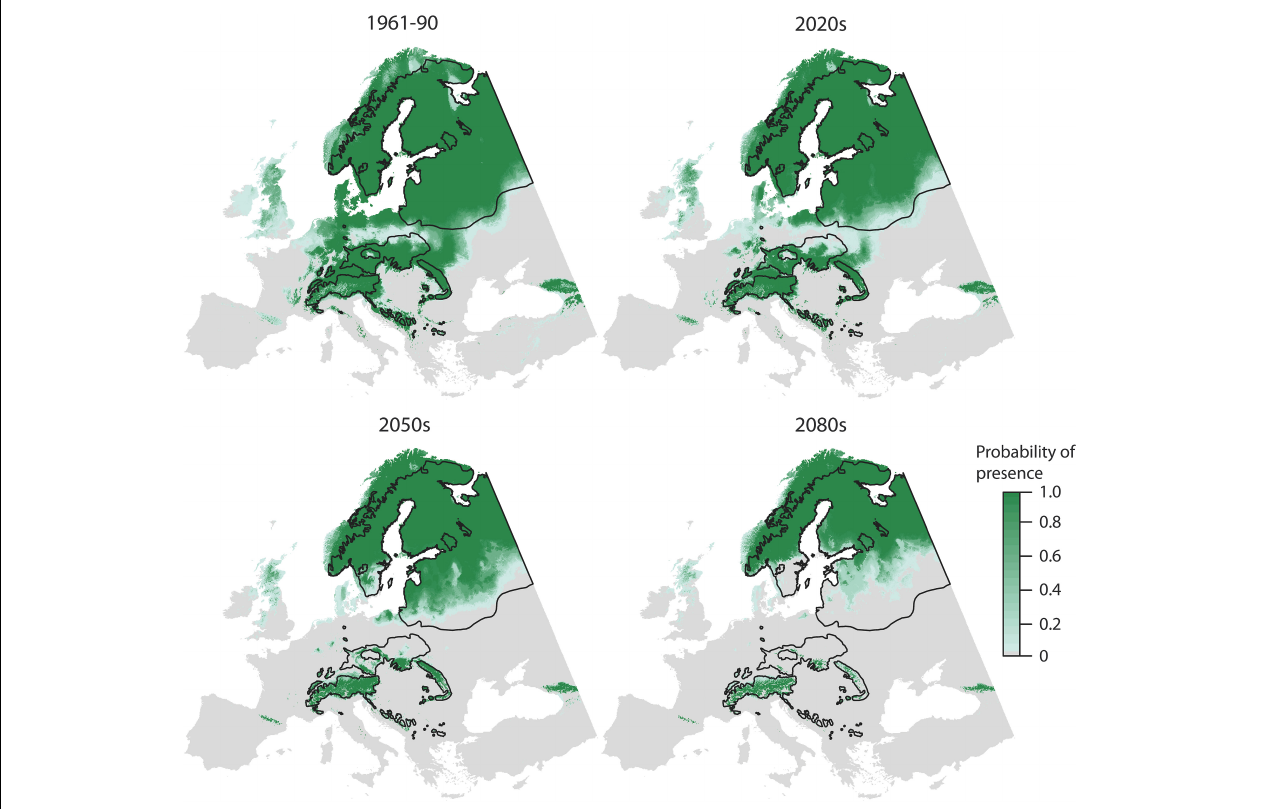
FIGURE 2 | Probability of presence according to OccurrenceSDM for the 1961–1990 reference period and three projections for the 2020s, 2050s, and 2080s. Black lines indicate the natural